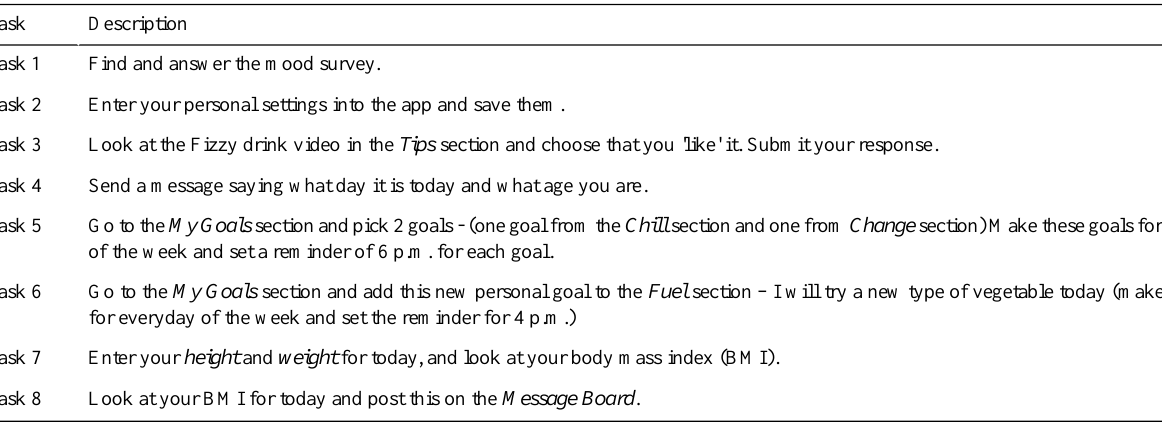
Table 1. Testing tasks.